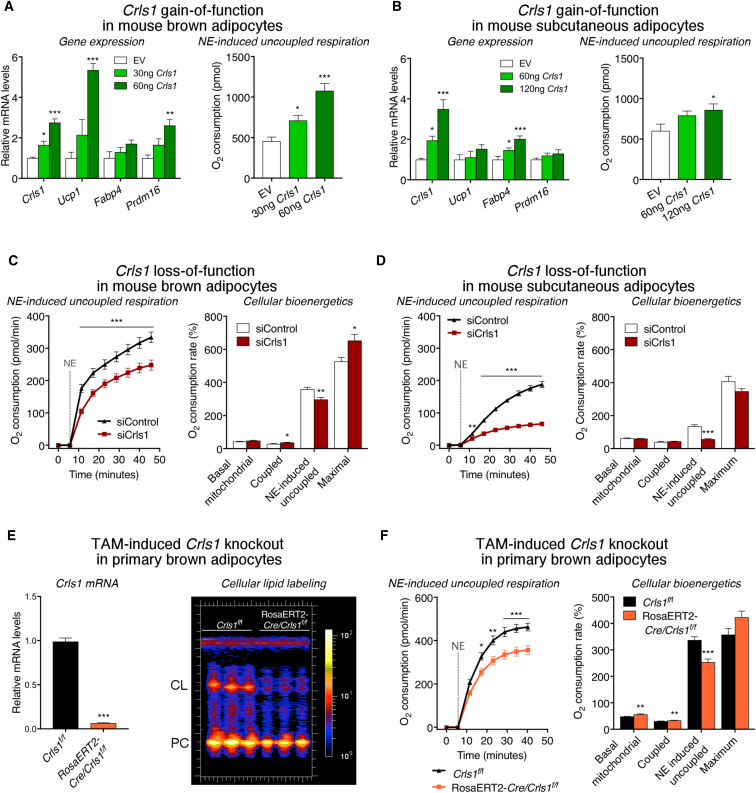
CRLS1 Enhances Inducible Uncoupling in Thermogenic Fat Cells(A–D) Gene expression and NE-induced respiration from primary brown (A) and subcutaneous (B) adipocytes electroporated with either empty pcDNA vector or vector expressing Crls1 (one-way ANOVA). Oxygen consumption profiles from control and Crls1 siRNA-treated (C) primary brown and (D) subcutaneous adipocytes following addition of oligomycin and NE stimulation (repeated measures two-way ANOVA). Quantified levels of basal, ATP synthesis-coupled, NE-induced uncoupled, and maximal respiration are provided to the right (t tests).(E and F) (E) Crls1 mRNA levels and cardiolipin (CL) labeling for 6 hr and (F) oxygen consumption profiles of primary brown adipocytes from control Crls1f/f and Rosa26ERT2-Cre/Crls1f/f mice treated with tamoxifen (TAM). Data are presented as means ± SEM. ∗p < 0.05; ∗∗p < 0.01; ∗∗∗p < 0.001.See also Figure S3.